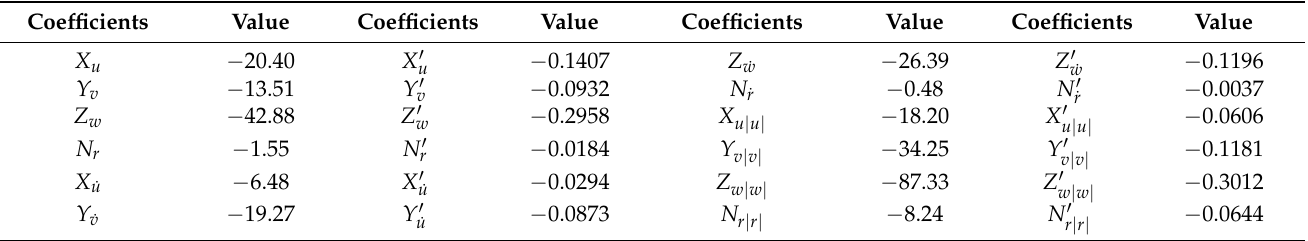
Table 9. Numerical results of hydrodynamic coefficients estimation by towing test simulation, rotating arm test simulation, and PMM test simulation. The corresponding non-dimensional hydrodynamic coefficients are marked with (cid:48) .